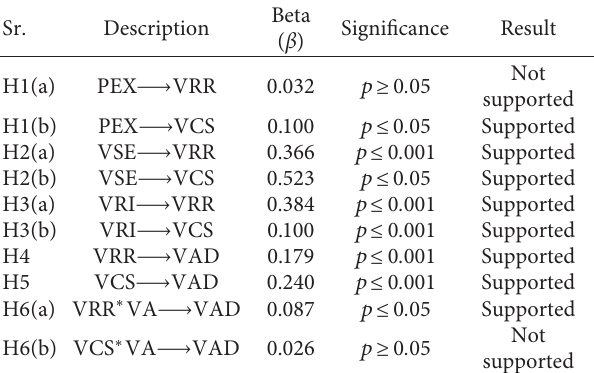
Table 6: Hypotheses testing (path analysis).